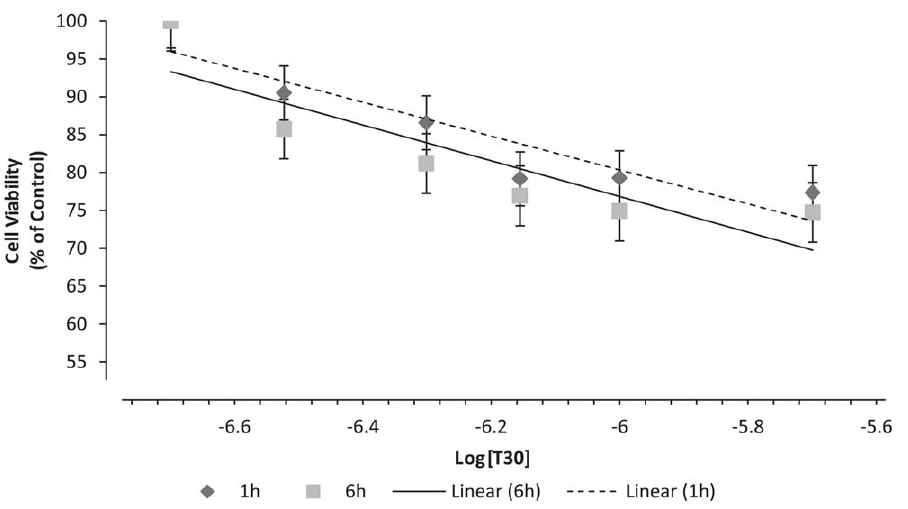
Figure 2. Dose-response curves representing cell viability (% of control) after 1 and 6 h of treatment with AChE C-terminus peptides of 30 amino acids (T30) with concentrations. Data are presented as the percentage (of control) of the mean 6 S.E.M. from five independent experiments carried out on triplicates (* P , 0.05, N=5).